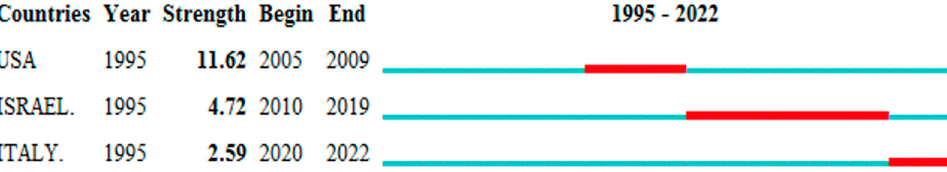
Figure 3. Top 3 countries with strongest citation bursts.